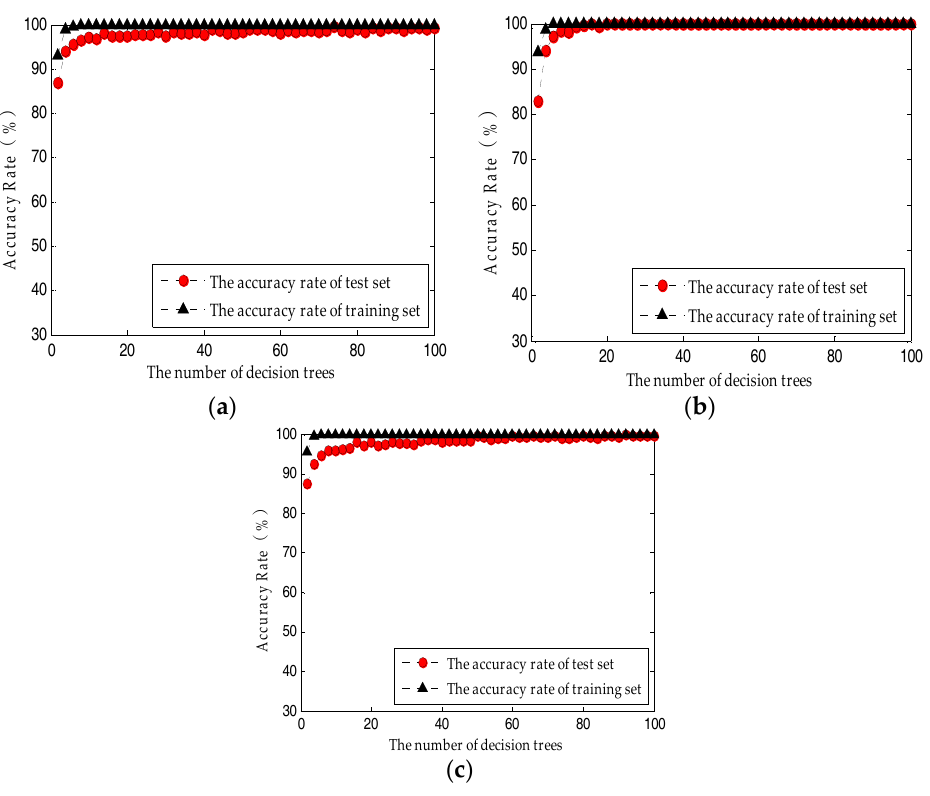
Figure 6. The influence of the number of decision trees on RF performance: ( a ) Based on the PCA-optimized feature set; ( b ) Based on the PLS-optimized feature set; ( c ) Based on the original feature set.